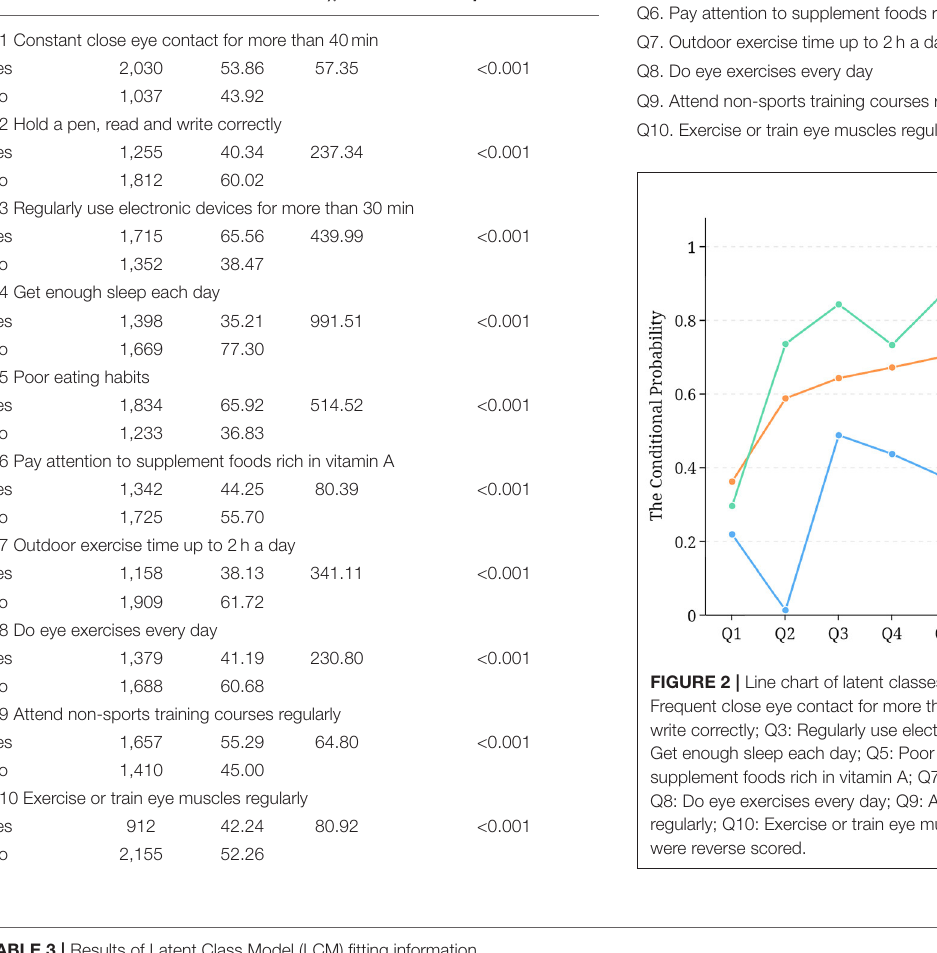
TABLE 3 | Results of Latent Class Model (LCM) fitting